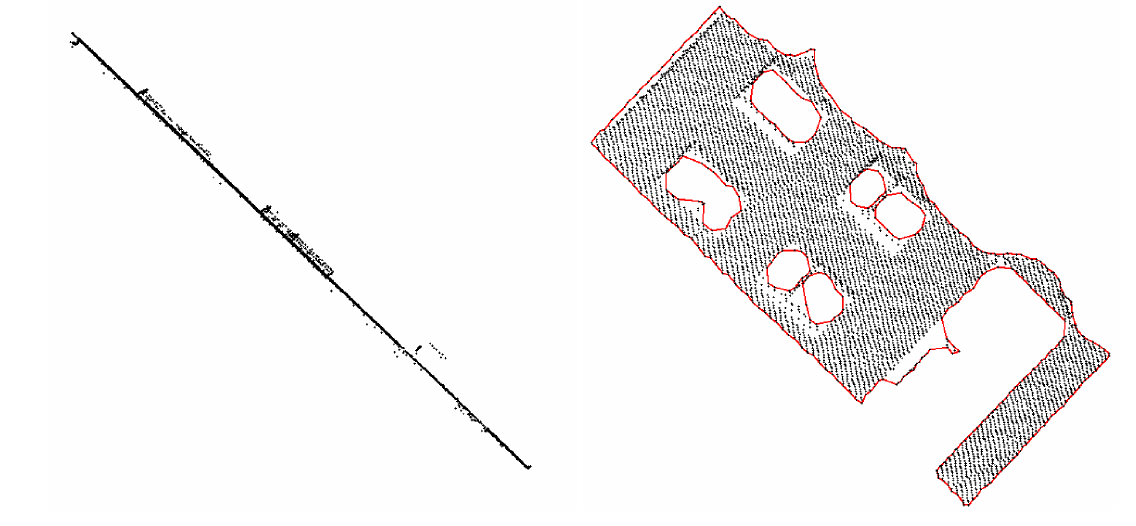
Figure 7. Points belonging to a building facade segment are projected on the XY-plane to calculate its area. Locations that are not part of a segment such as windows are excluded from area